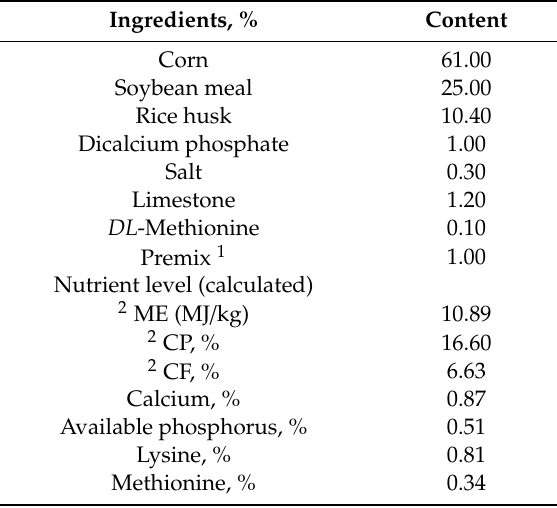
Table 1. Composition and nutrient levels of the diet (as-fed